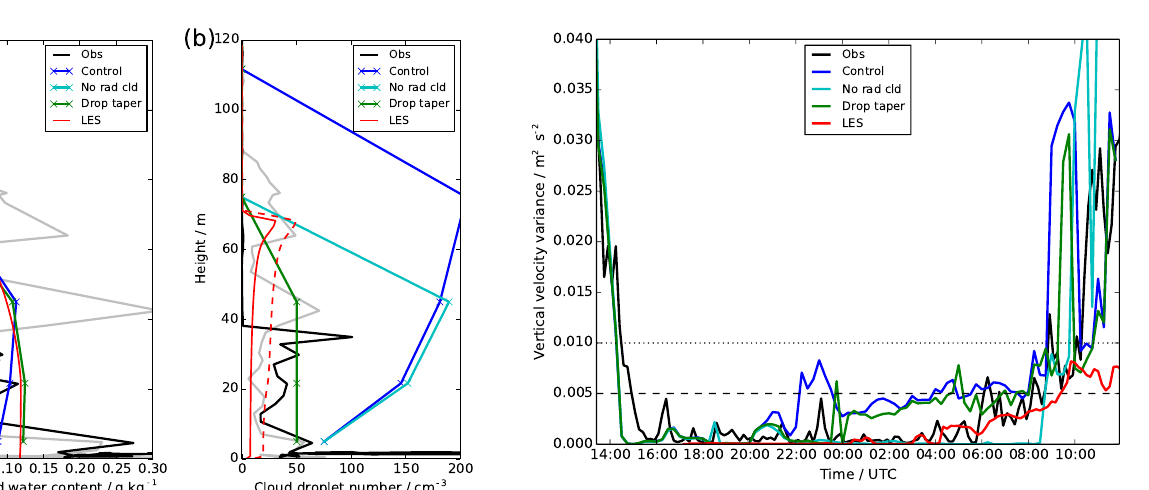
Figure 5. Profiles at 00:30UTC showing observations (00:00UTC: grey, 00:30UTC: black), LES (red) and UKV experiments: control (blue), radiatively inactive cloud (cyan) and modified droplet num- ber (green), showing (a) cloud liquid water content and (b) cloud droplet number concentration. For the LES droplet number, we show only the activated droplets (solid) and all particles > 2µm (dashed).